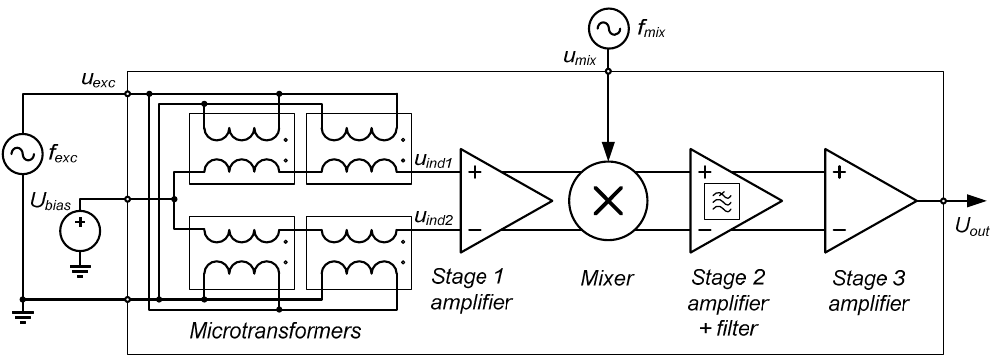
Figure 10. The measurement channel for a single chain of microtransformers, as realized in the prototype ASIC. For the described synchronous demodulation method, f mix equals f exc . The DC biasing voltage of the IC U bias is set to 2.5 V, i.e. , to the half of supply voltage (5 V).